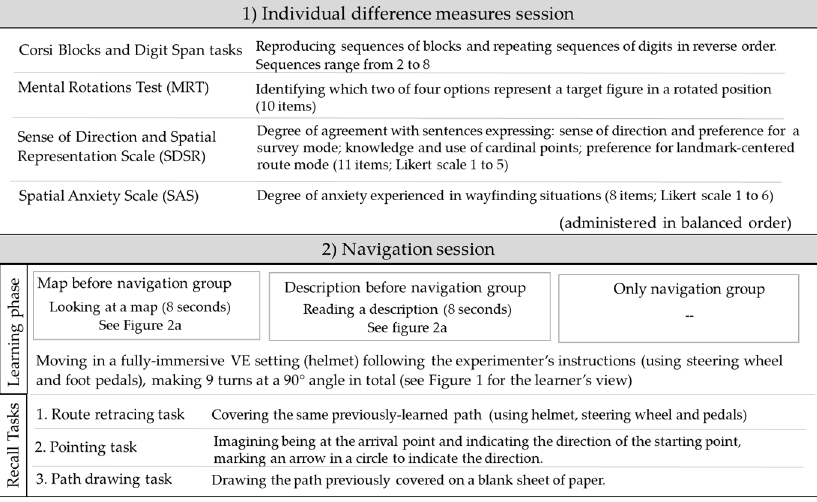
Figure 3. Summary of materials and procedure.